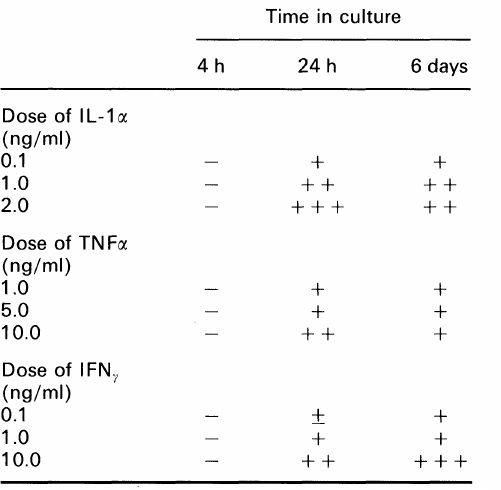
Mediators of Inflammation.